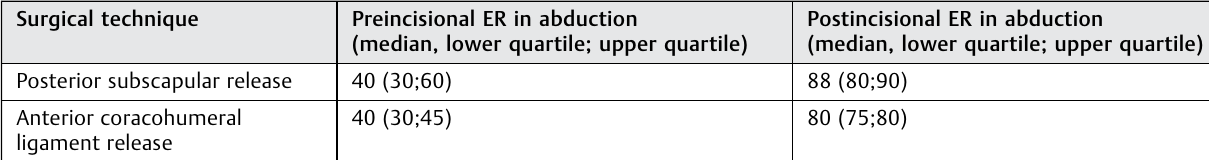
Table 3 Pre- and postincisional ER in abduction in both groups Surgical